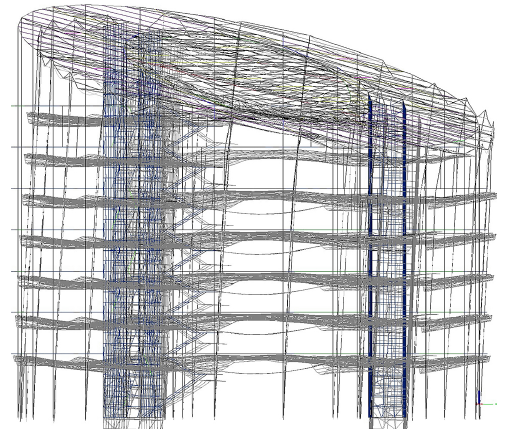
Fig. 9. A deformed shape of the structure: a combination of self weight, live load and wind